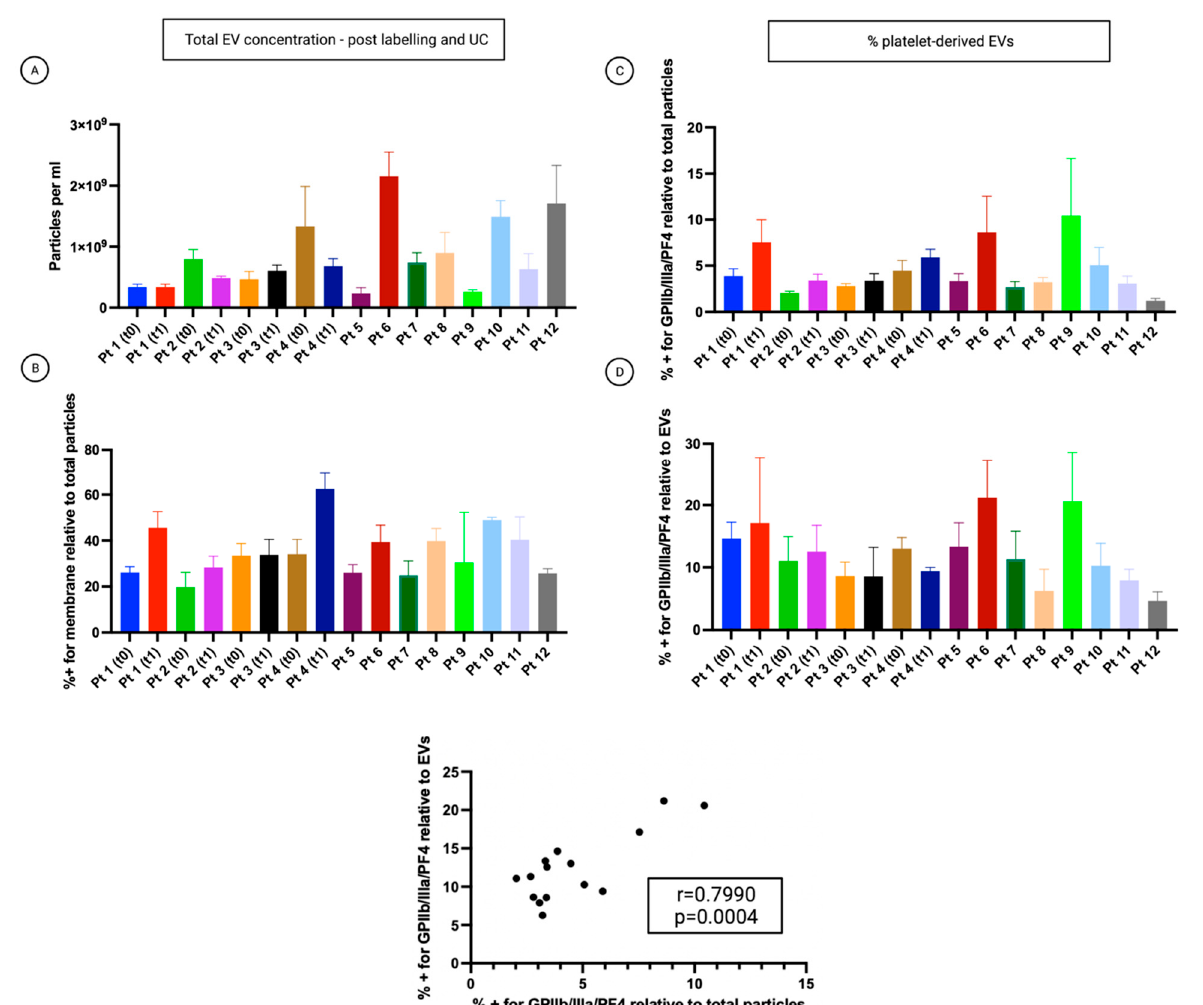
Figure 4. Analysis of the small-EVs from ascites on the cohort of patients. The patient’s number corresponds to Table 1. T0: time of diagnosis before starting neoadjuvant chemotherapy (NACT). T1: time of interval debulking surgery (IDS). Data are reported as means ± SD of one experiment performed in triplicate. ( A ) The concentration of all particles > 45 nm. ( B ) Percentage of all particles > 45 nm, which also showed CellMask™ labelling (thus determined as EVs). ( C ) Percentage of all particles > 45 nm, which also showed labelling for at least one platelet marker. ( D ) The percentage of CellMask™ positive particles (EVs) is also positive for one or more platelet markers.